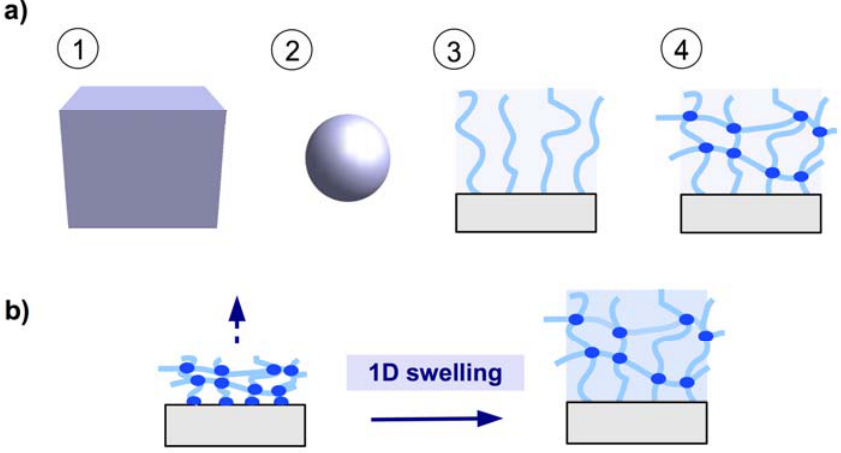
Figure 1. ( a ) Schematic representation of hydrogel formats (1) 3D bulk gel, (2) microgel particle, (3) brush layer, and (4) surface-attached polymer network. ( b ) Surface-attached polymer network swelling in one dimension away from the